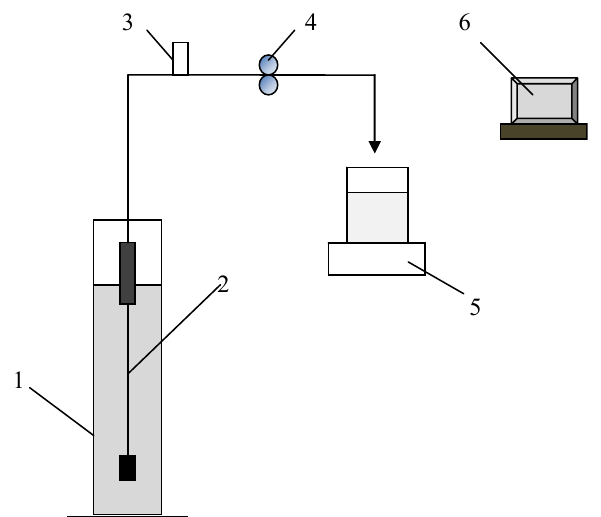
Figure 1. Schematic of the experimental